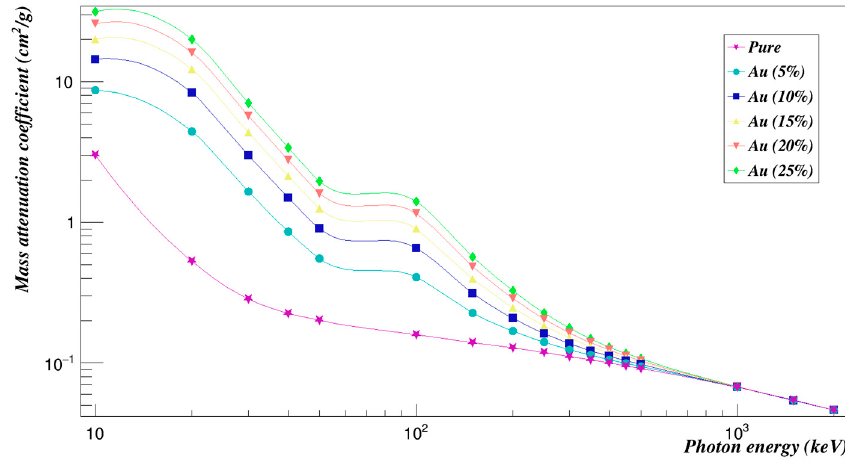
Figure 14. Photon mass attenuation coefficients of Polyimide doped with gold.